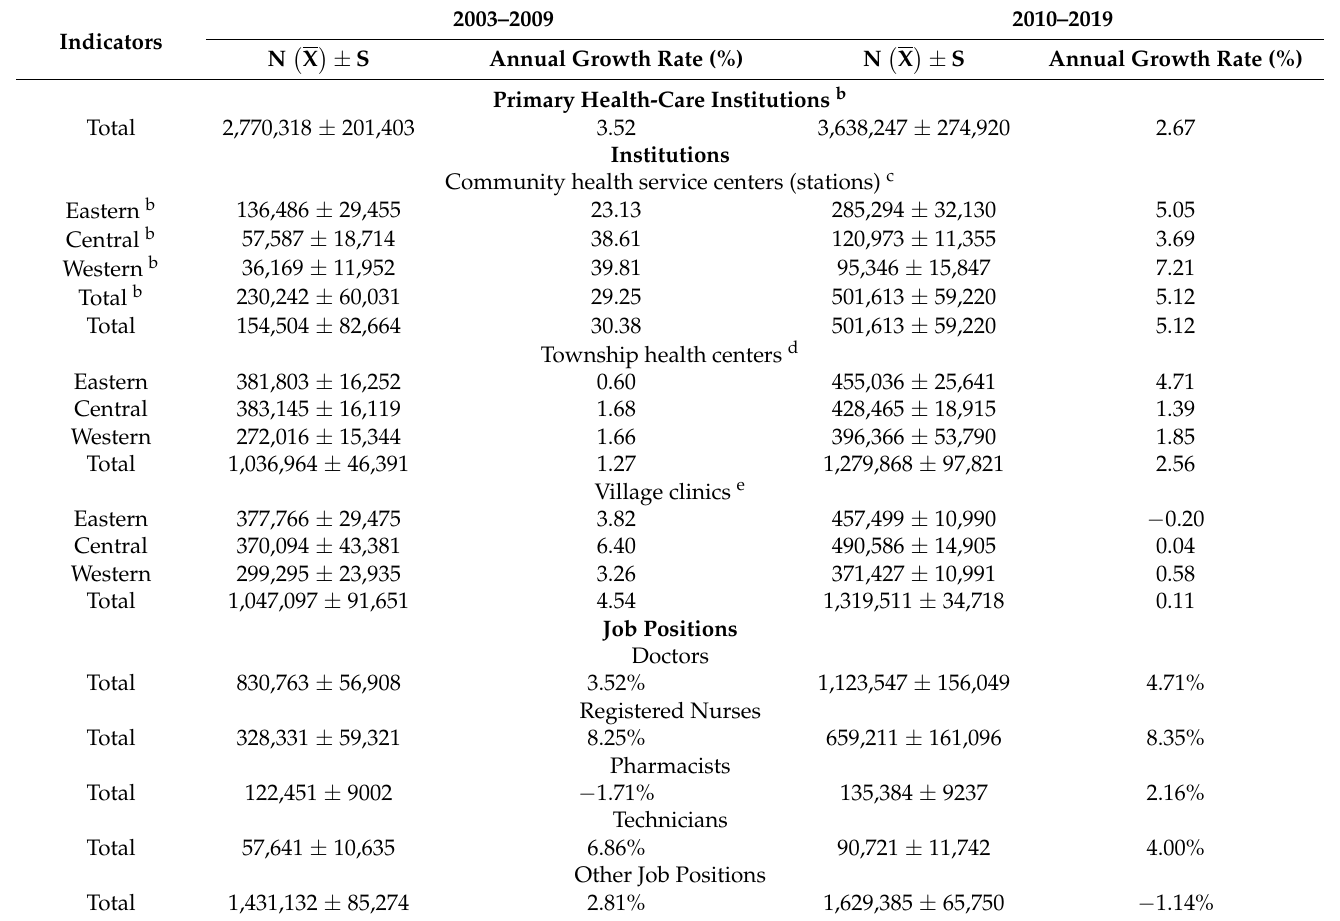
Table 1. Changes in the number of staff in primary health-care institutions in China a